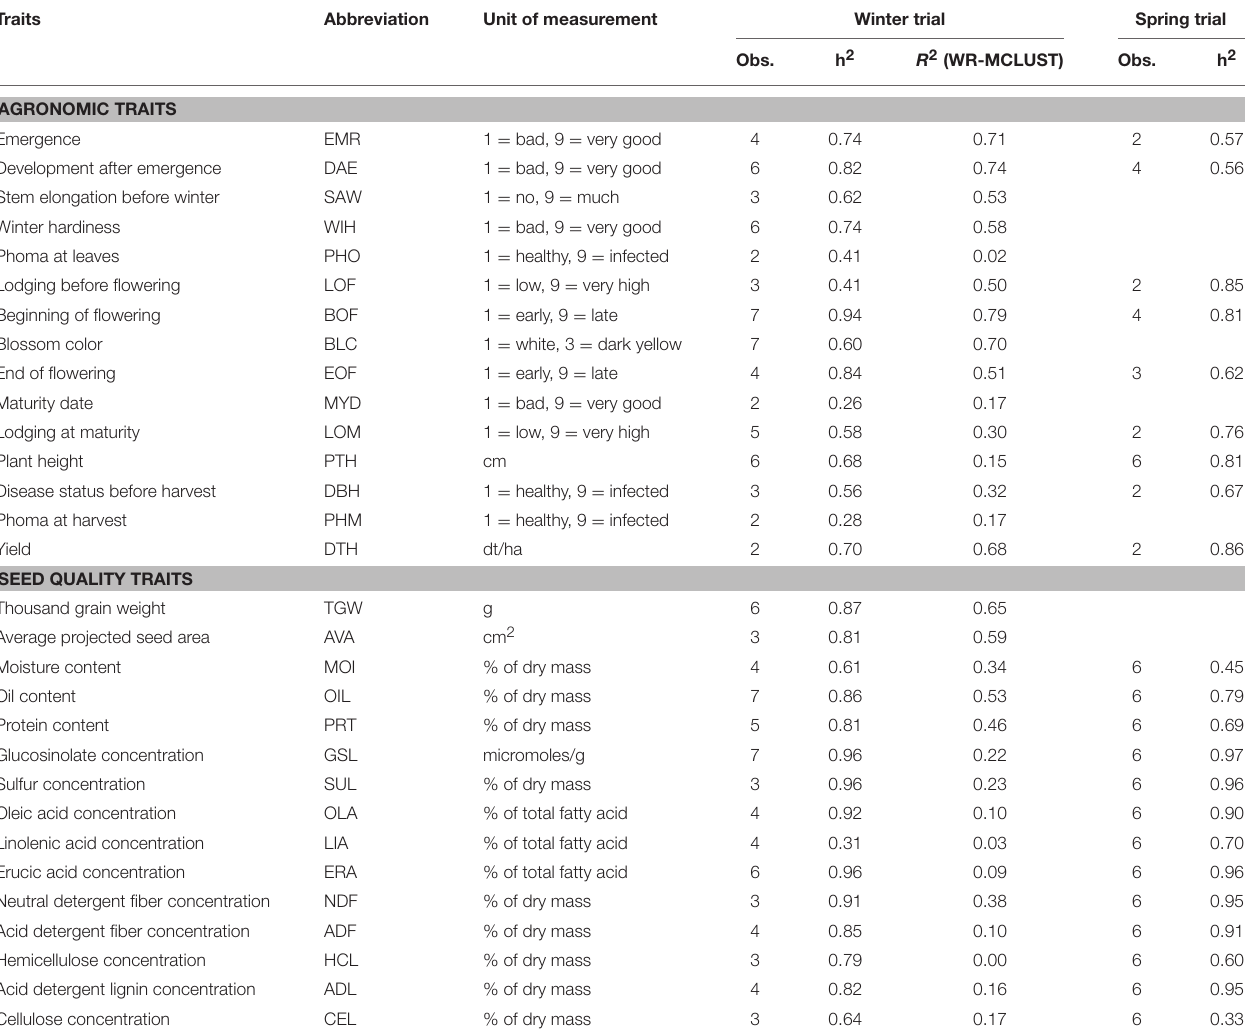
TABLE 1 | Traits assessed in the B. napus diversity set, where h 2 is the repeatability, R 2 the proportion of the phenotypic variance explained by population structure, and Obs. the number of replicates or location-replicate combinations in which the corresponding trait was